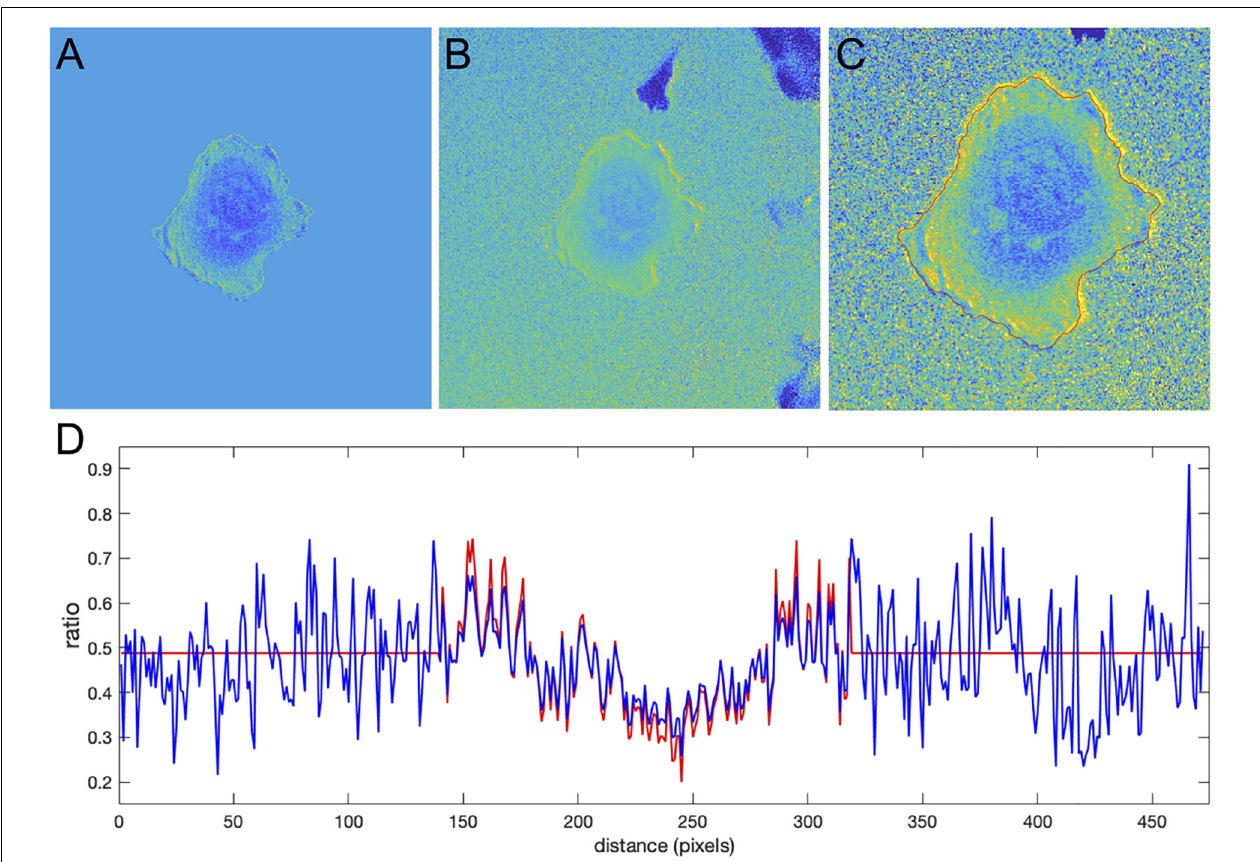
FIGURE 9 | Application of the correction factor method to the Cdc42 biosensor data. (A) The ratio image resulting from the mean background subtraction method. The background level is set to the mean value of the ratio inside the cell. (B) The ratio image resulting from the correction factor method. Now with the ratio signal in the background, a shade-like bias from the bottom-left to the top-right sides of the cell becomes clearly visible. (C) A zoomed-in image of the cell with the cell outline highlighted in red. The image shows that the artifact is mostly present outside the cell so that the ratio calculation inside the cell away from the edge should be accurate in both methods, but the bias is still present at the very edge. (D) The ratio values along a horizontal line running across the whole image. Red and blue colors represent the results of the mean background subtraction and correction factor methods,